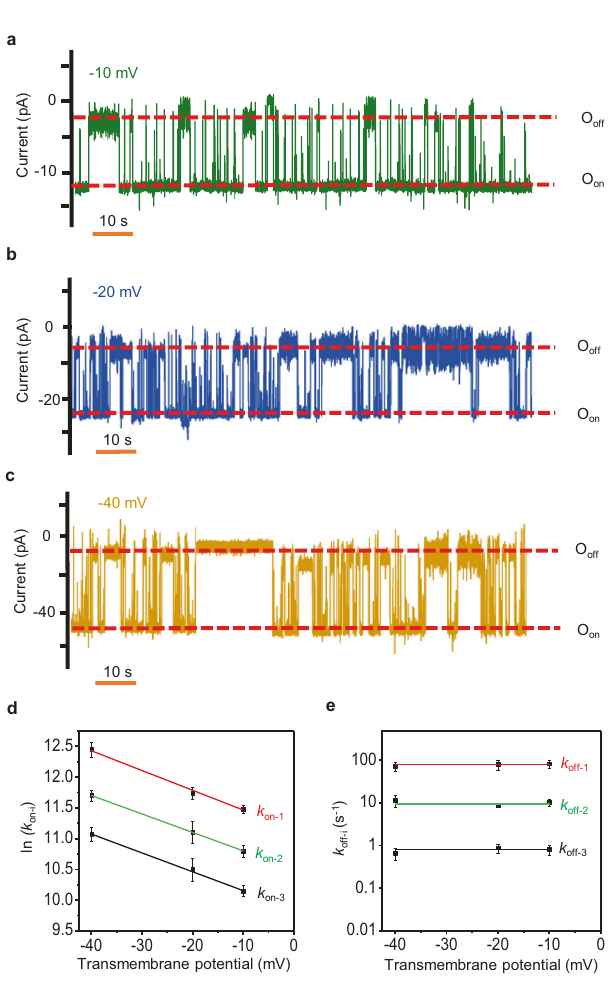
Fig. 5 Voltage dependence of MLL4 Win -WDR5 interactions. a Reversible WDR5 captures were observed through current transitions between the O on and O off substates of MLL4 Win tFhuA at an applied transmembrane potential of − 10 mV. b The same as in ( a ), but at an applied transmembrane potential of − 20 mV. c The same as in ( a ), but at an applied transmembrane potential of − 40 mV. O on and O off are release and capture substates, respectively. This single-channel electrical signature was replicated in three independent experiments. Single-channel electrical traces in ( a ) – ( c ) were low-pass fi ltered at 100 Hz using an 8-pole Bessel fi lter. d Linear plot in a semilogarithmic representation, which shows the dependence of ln ( k on-i ) on the transmembrane potential, where i = 1, 2, and 3. Here, k on-i , with i = 1, 2, and 3, are the association rate constants of short-, medium, and long-lived binding events, respectively. e The dependence of k k i = 1, 2, and 3, are the off-i on the transmembrane potential. Here, off-i , with reciprocal of mean durations of short-, medium-, and long-lived WDR5 captures, respectively. In ( d ) and ( e ), data points represent mean ±s.d. obtained from n = 3 distinct experiments. 8 μ M [WDR5] was added to the cis compartment. Source data are provided as a Source Data fi le.